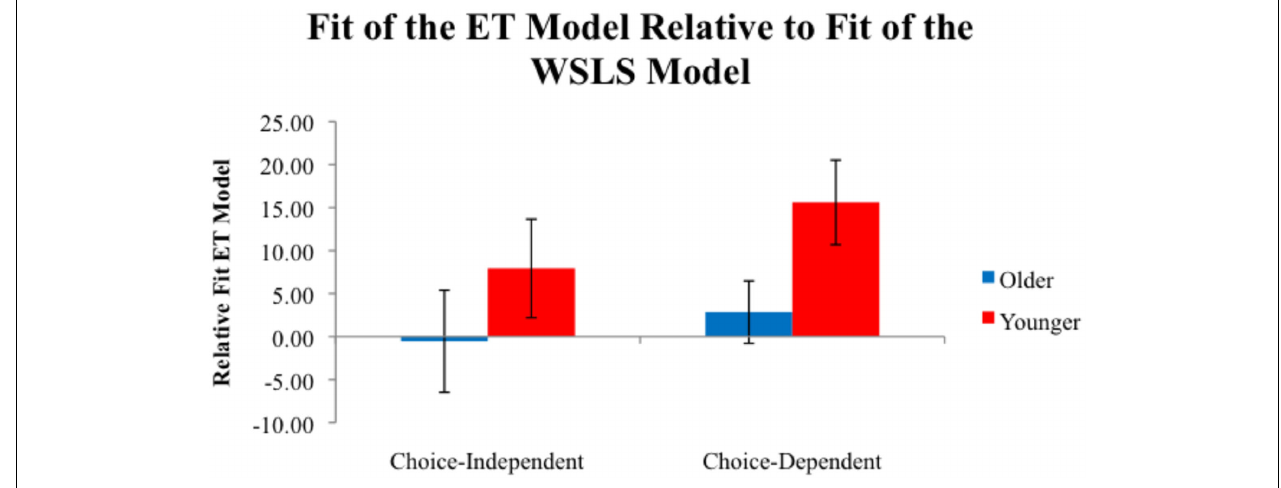
FIGURE 5 |Average Relative fit ET values for participants in each condition. Positive values indicate a better fit for the ET model, while negative values indicate a better fit for theWSLS model.